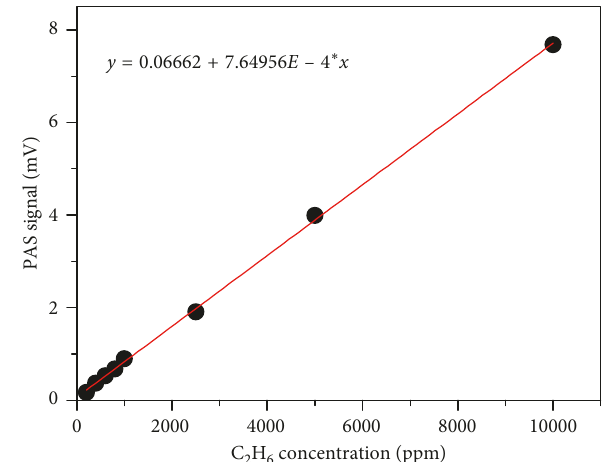
Figure 5: Linear response of the PAS signals to C